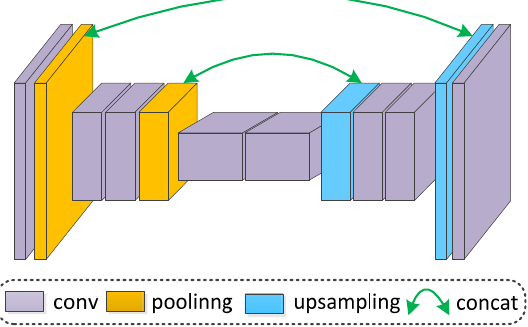
Figure 2. Much location information is lost after encoding. The initial location information cannot be obtained after